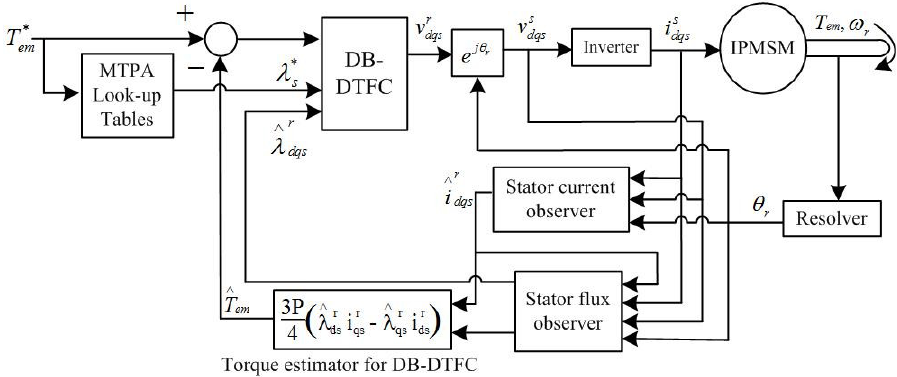
Figure 6. A block diagram of a DB-DTFC IPMSM (interior permanent magnet synchronous motor) drive.